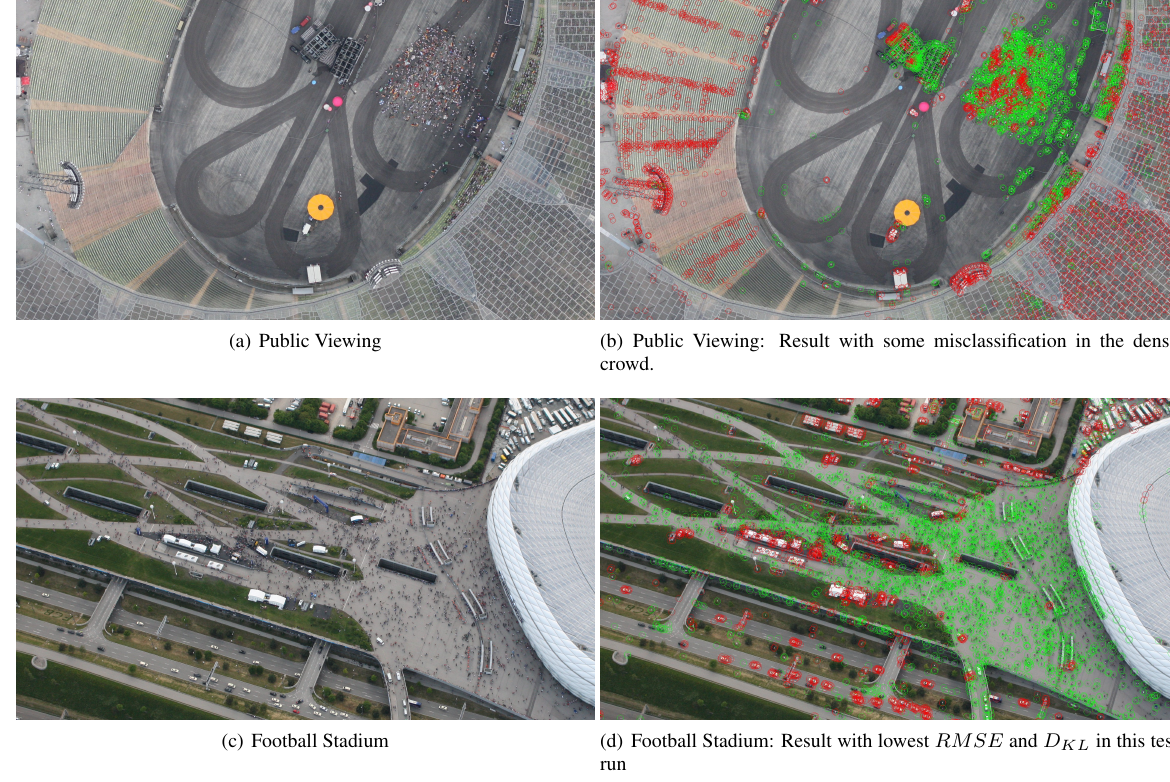
Figure 3: Test images with classification results of the detected interest points. green ˆ= classified as crowd, red ˆ= classified as non-crowd Each camera has a full frame CMOS sensor with a resolution of 21 MPix. The used lenses are a Zeiss Makro Planar 2/50mm and a Zeiss Distagon T 2/35mm.